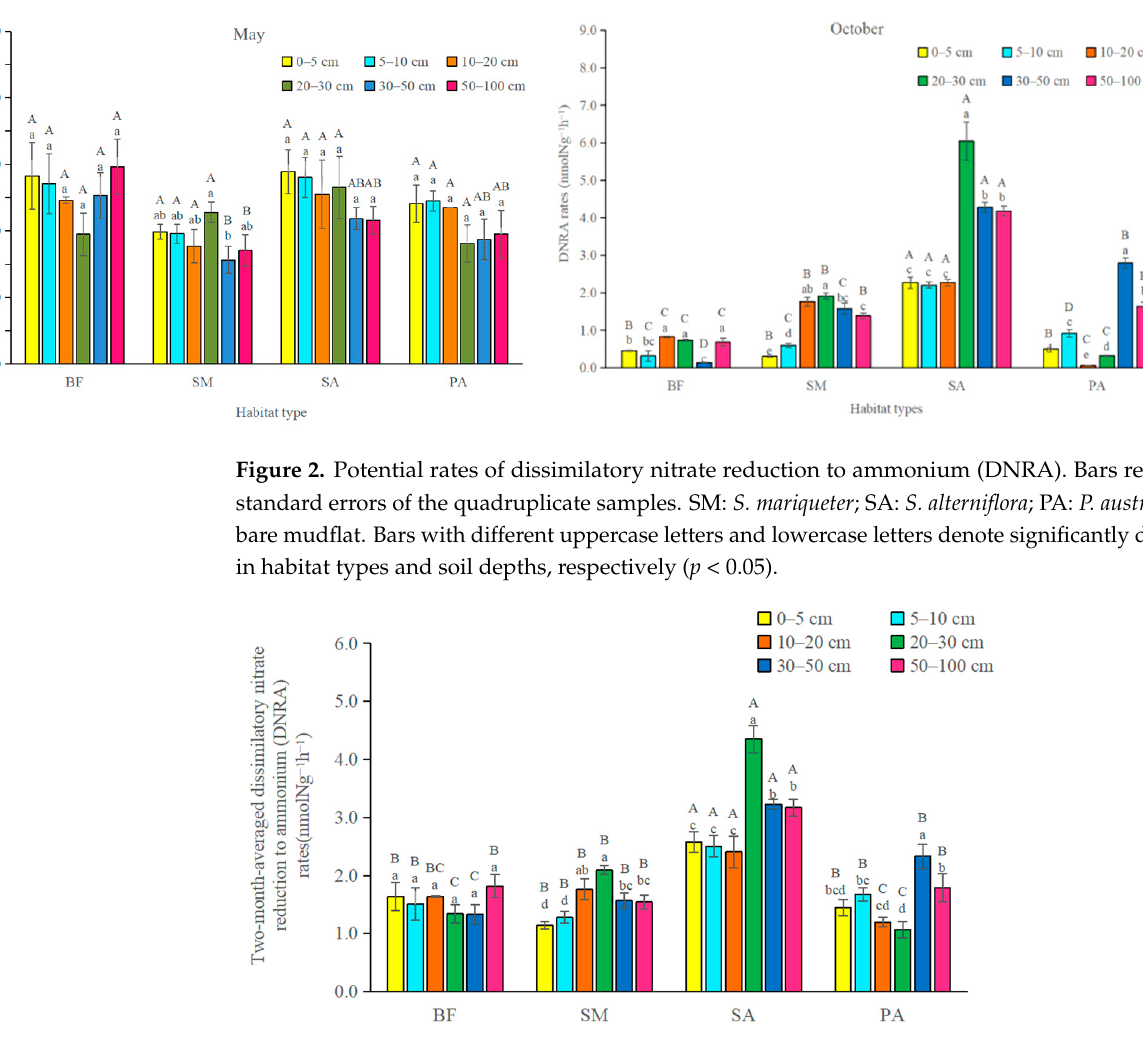
Figure 3. Two-month-averaged dissimilatory nitrate reduction to ammonium (DNRA) rates. Error bars in the column represent standard errors. SM: S. mariqueter ; SA: S. alterniflora ; PA: P. australis ; BF: bare mudflat. Bars with different uppercase letters and lowercase letters denote significantly different in habitat types and soil depths, respectively ( p < 0.05).